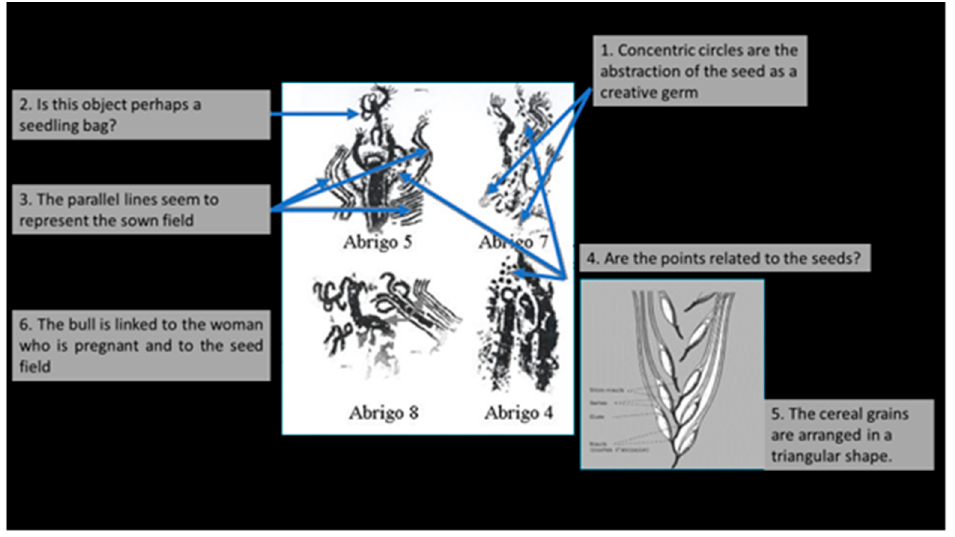
Figure 25. Pla de Petracos appears to associate Mother Nature with the seed, the sown field, and the